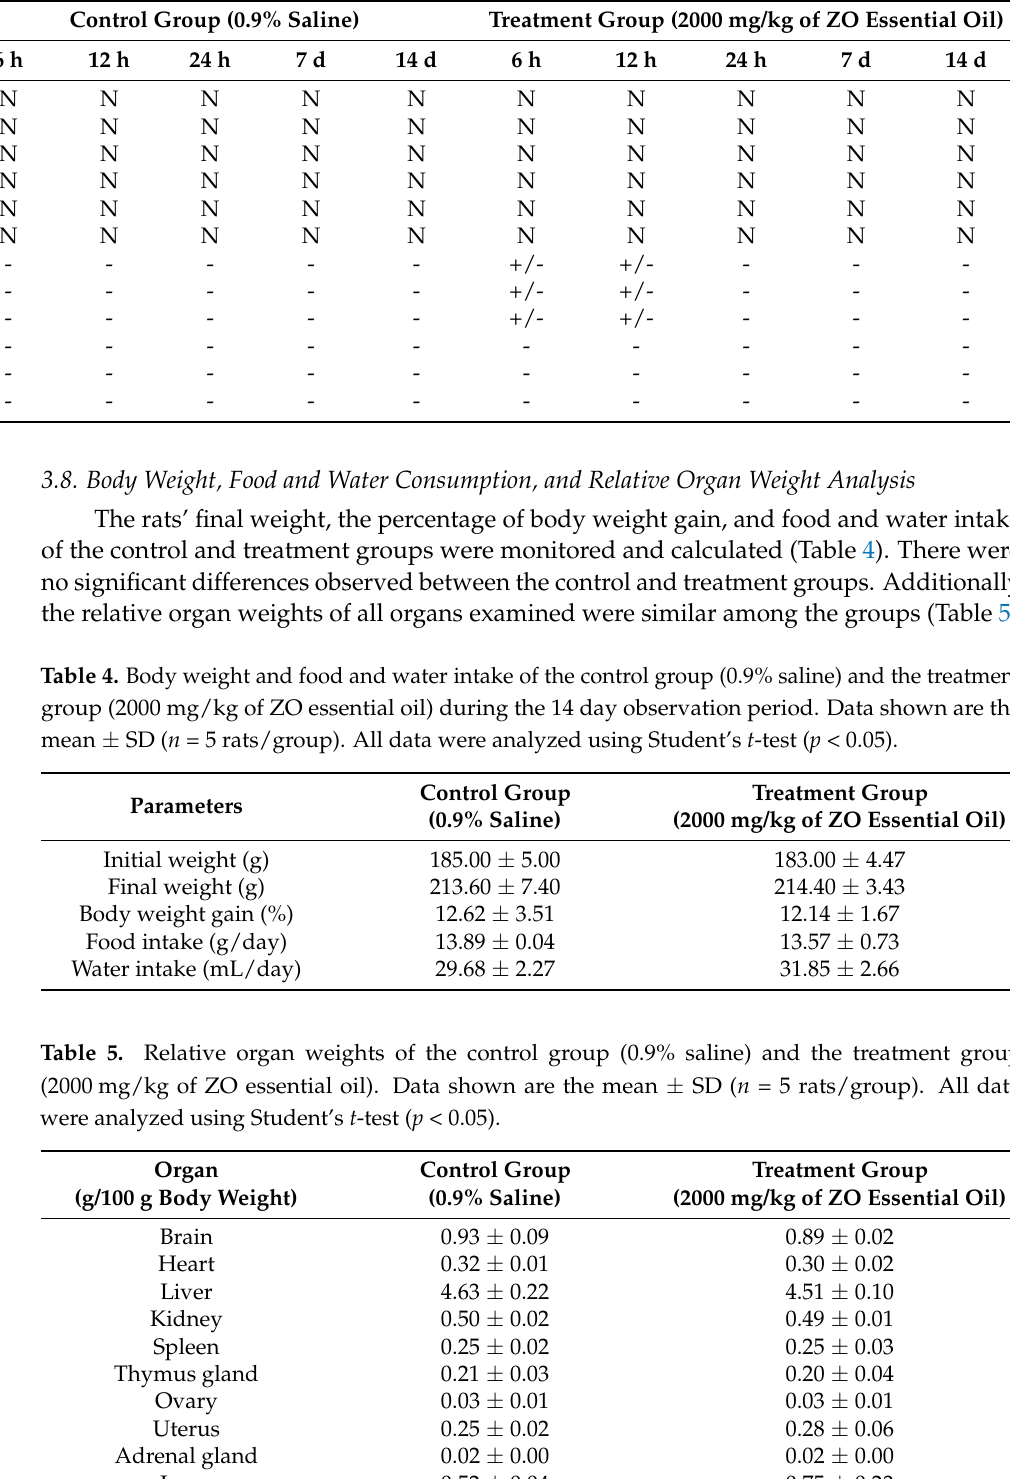
Table 3. General appearance and behavioral observations of the control group (0.9% saline) and the treatment group (2000 mg/kg of ZO essential oil) over the period from 6 h to 14 days after administration. N = normal, + = detected and - = not detected.